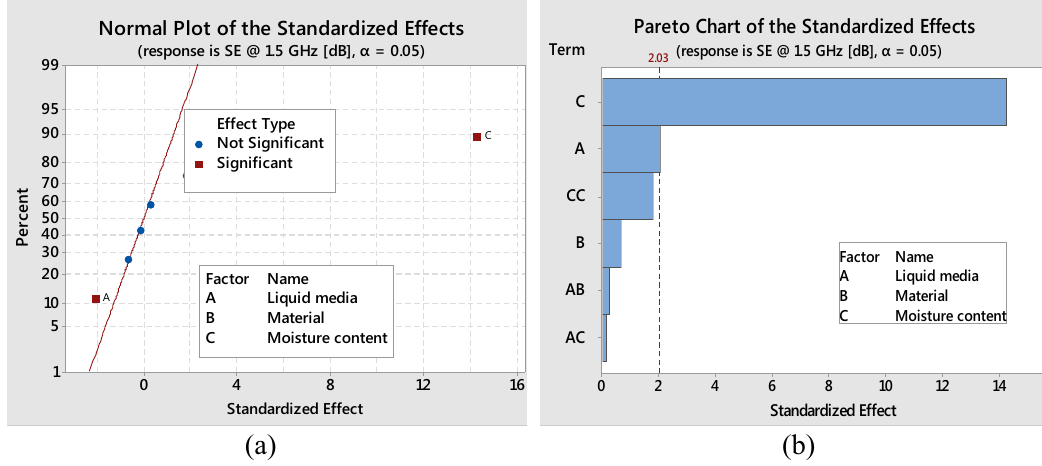
Figure 2. Standardised effects on SE (dB) at 1.5 GHz: ( a ) normal plots and ( b ) Pareto chart.